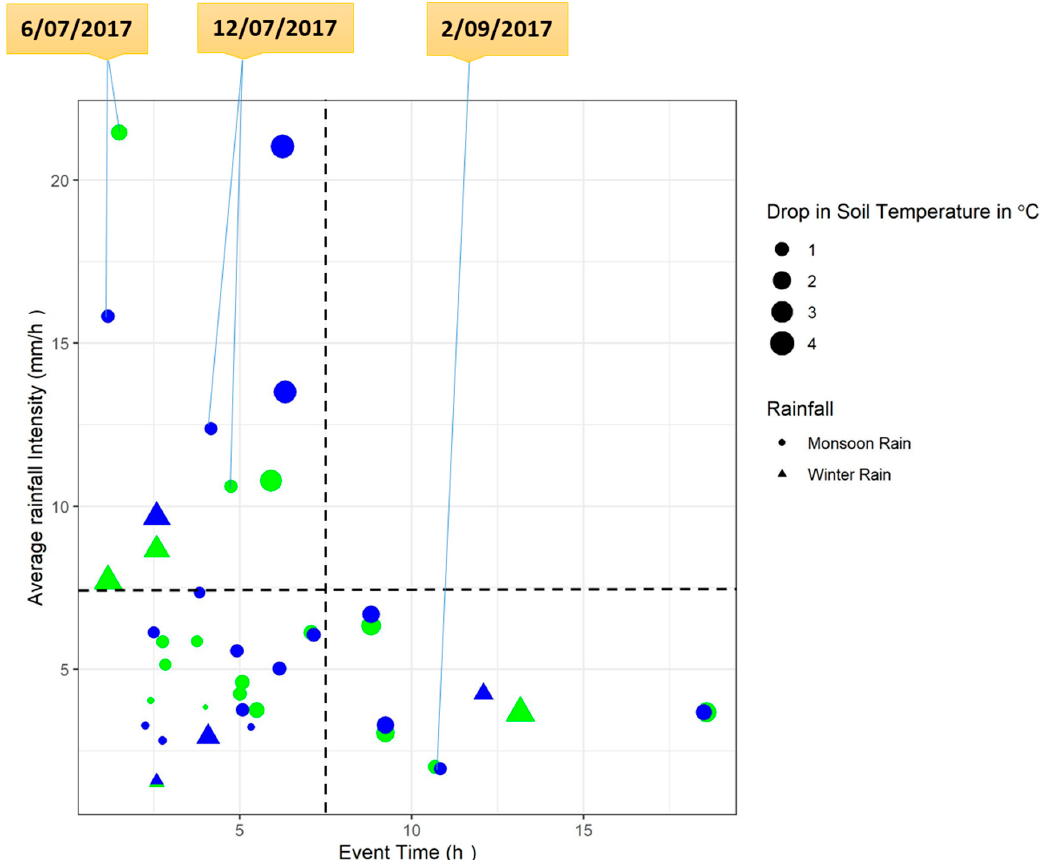
Figure 6. Event duration (h) versus event average rainfall intensity (mm/h); size of the bubble shows the drop in temperature (°C); blue and green colors represent AgF and GA hillslopes, respectively.